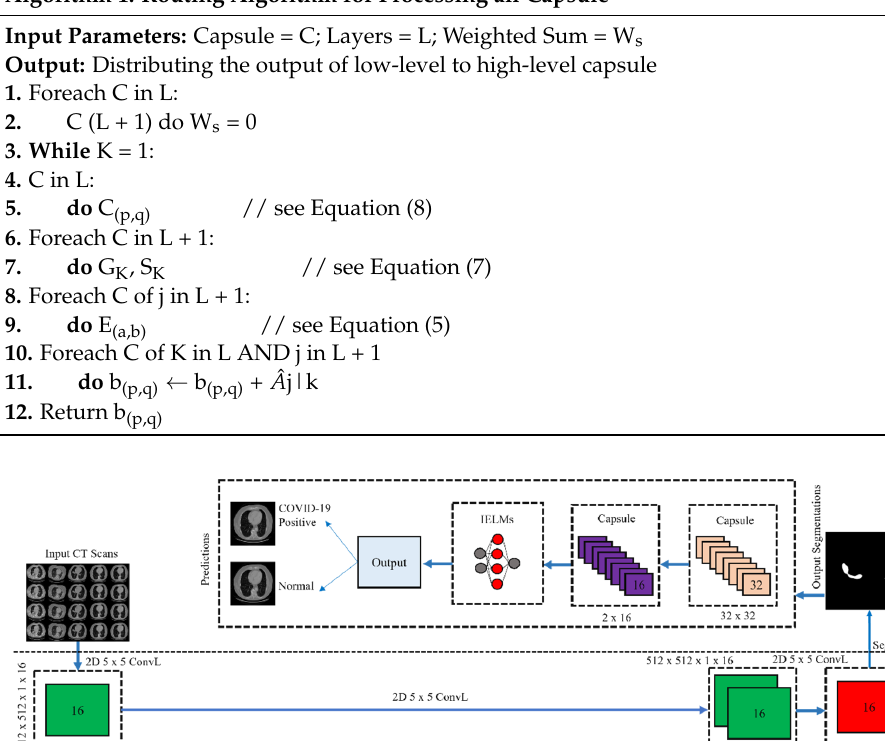
Algorithm 1: Routing Algorithm for Processing all Capsule